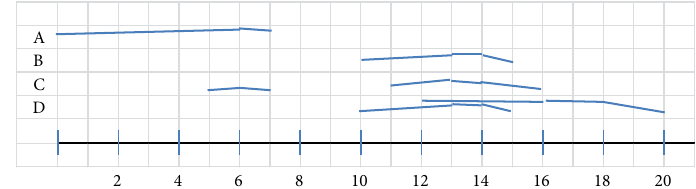
Figure 3. Schedule according to the earliest dates using fuzzy values